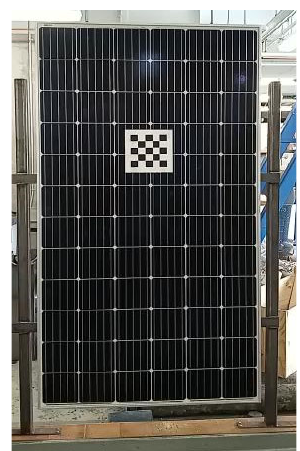
Figure 10. The solar frame used to monitor the true displacement induced by force.